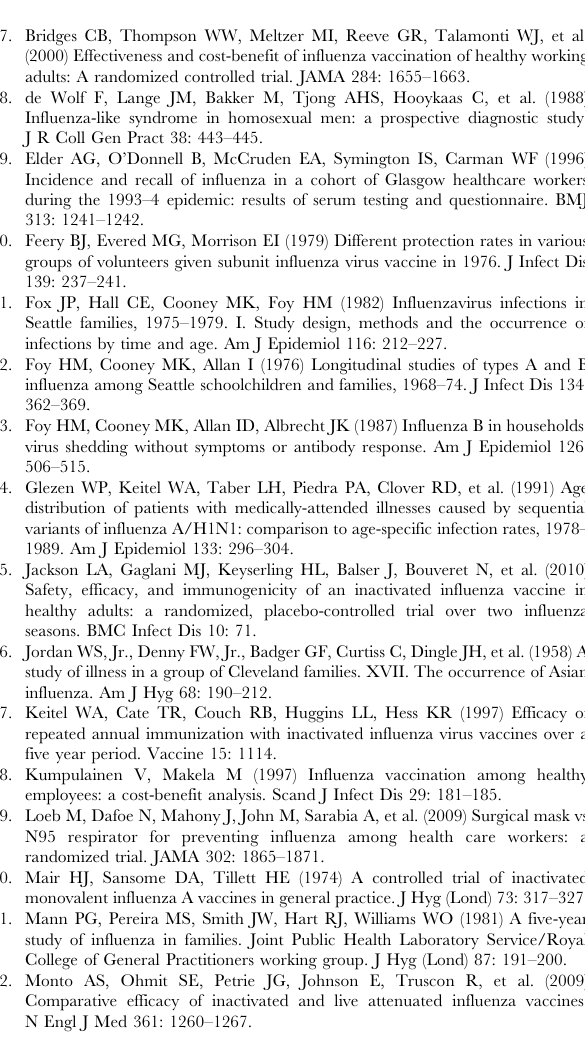
Table S1 Assessment of quality of included studies.